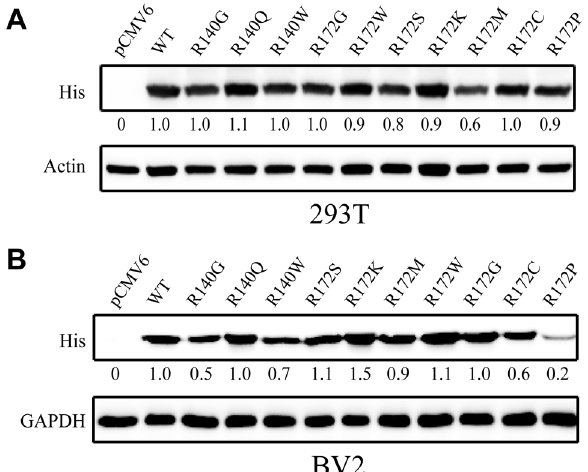
Figure 2. Overexpression of IDH2 WT and mutants in the 293T or BV2 cell line was assessed by western blotting using anti-His antibody at 48 h posttransfection. Actin or GAPDH staining was used as a loading control.